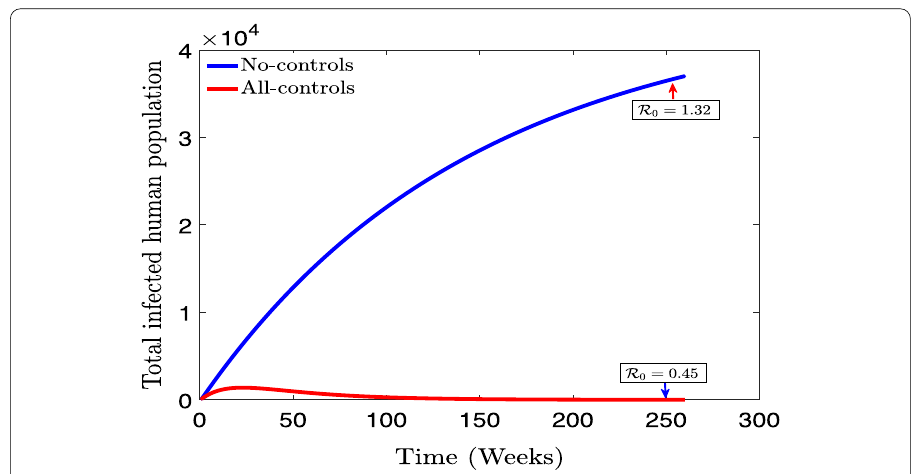
Fig. 9 Simulation of the dynamic of Lassa fever model (1), using parameter values as given in Table 2 such that R 0 = 1.32 > 1 (No-controls) and parameter values as given in Table 2, except for